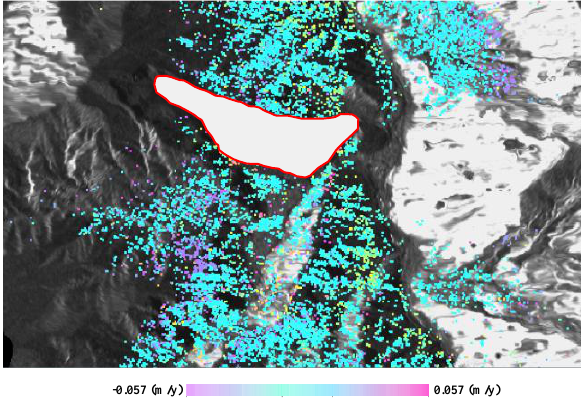
Figure 7. Persistent Scatterers (PS) selected by IPTA superimposed on Digital Elevation Model (DEM). Different colours correspond to different deformation rates.